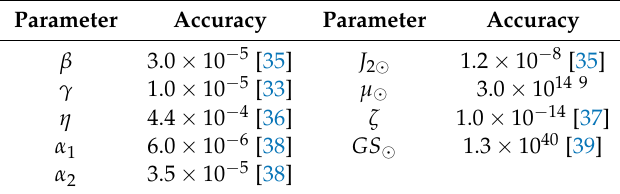
Table 1. Present knowledge of the relativity